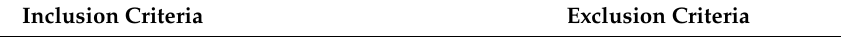
Figure 1. PRISMA flow diagram of study selection. Table 1. Study inclusion and exclusion